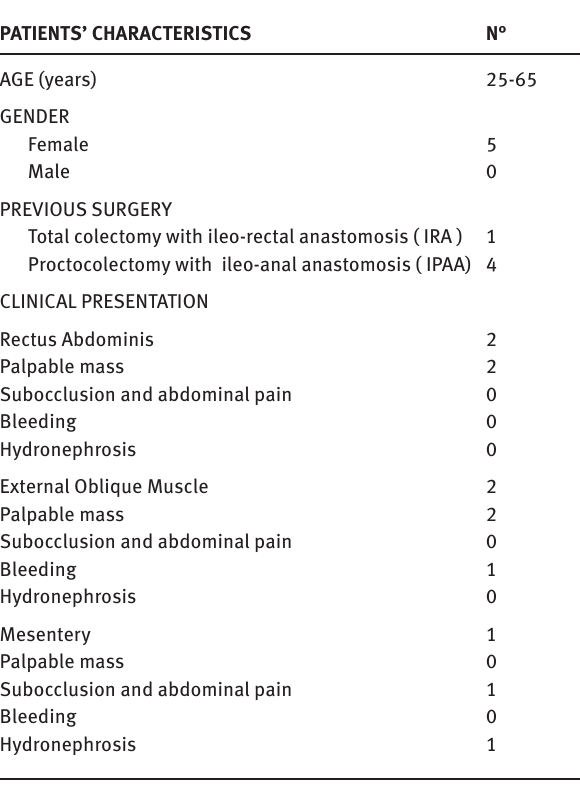
PATIENTS’ CHARACTERISTICS